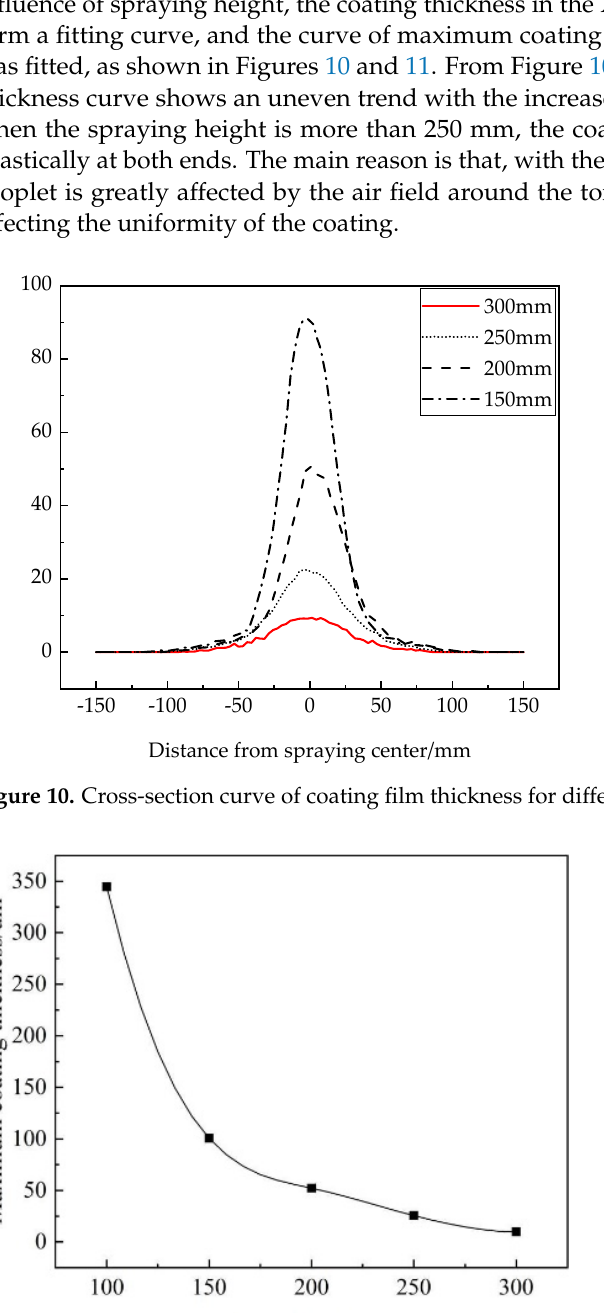
Figure 11. The law of maximum coating film thickness varying with spray height.